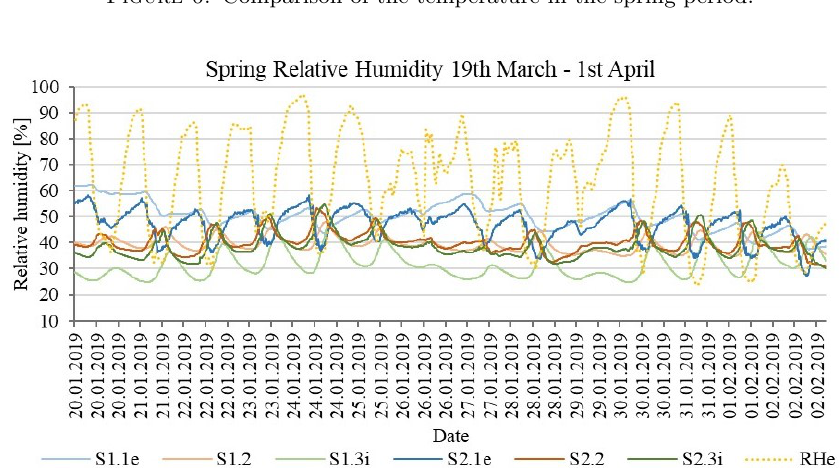
Figure 6. Comparison of the temperature in the spring period.